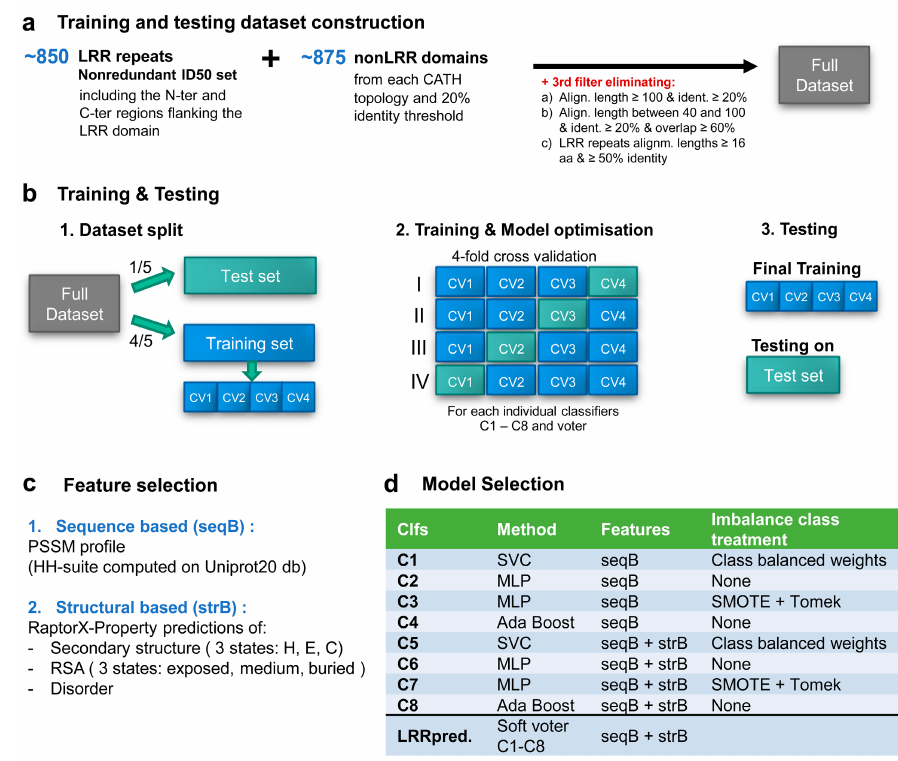
Figure 2. LRRpredictor training and testing workflow: ( a ) training and testing dataset construction. ( b ) schematic representation of the training and testing procedure, ( c ) selected features, and ( d ) selected classifiers aggregated into LRRpredictor.